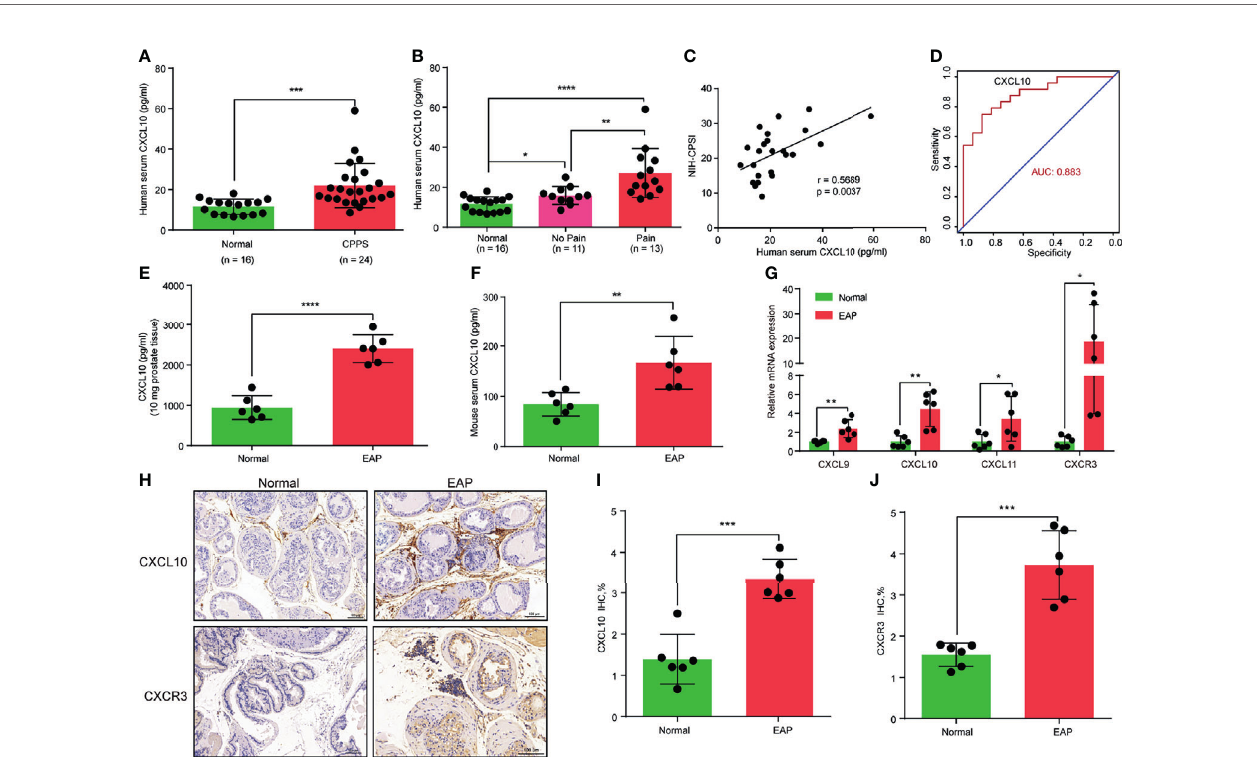
FIGURE 1 | CXCL10 expression is increased in chronic prostatitis patients and experimental autoimmune prostatitis (EAP) mice. (A) CXCL10 expression in the serum of chronic prostatitis patients and healthy volunteers. (B) CXCL10 expression in the serum of chronic prostatitis patients with and without pain symptom. (C) Pearson ’ s correlation coef fi cient analysis for CXCL10 expression and National Institutes of Health Chronic Prostatitis Symptom Index. (D) The diagnostic ef fi ciency of CXCL10 expression in the serum for chronic prostatitis patients. The expression levels of CXCL10 in prostate (E) and serum (F) of EAP mice. (G) RT-qPCR was used to assess CXCL9, CXCL10, CXCL11, and CXCR3 expressions in prostate from EAP mice. (H) IHC staining for CXCL10 and CXCR3 in prostate from EAP mice. Quanti fi cation of IHC staining of CXCL10 (I) and CXCR3 (J) in prostate from EAP mice. Data are shown as mean ± standard deviation (SD) by one-way ANOVA analysis (B) , or unpaired, two-tailed Student ’ s t -test analysis (A, E, F, G, I, J) , or Pearson ’ s correlation (C) . * P < 0.05; ** P < 0.01; *** P < 0.001; **** P <